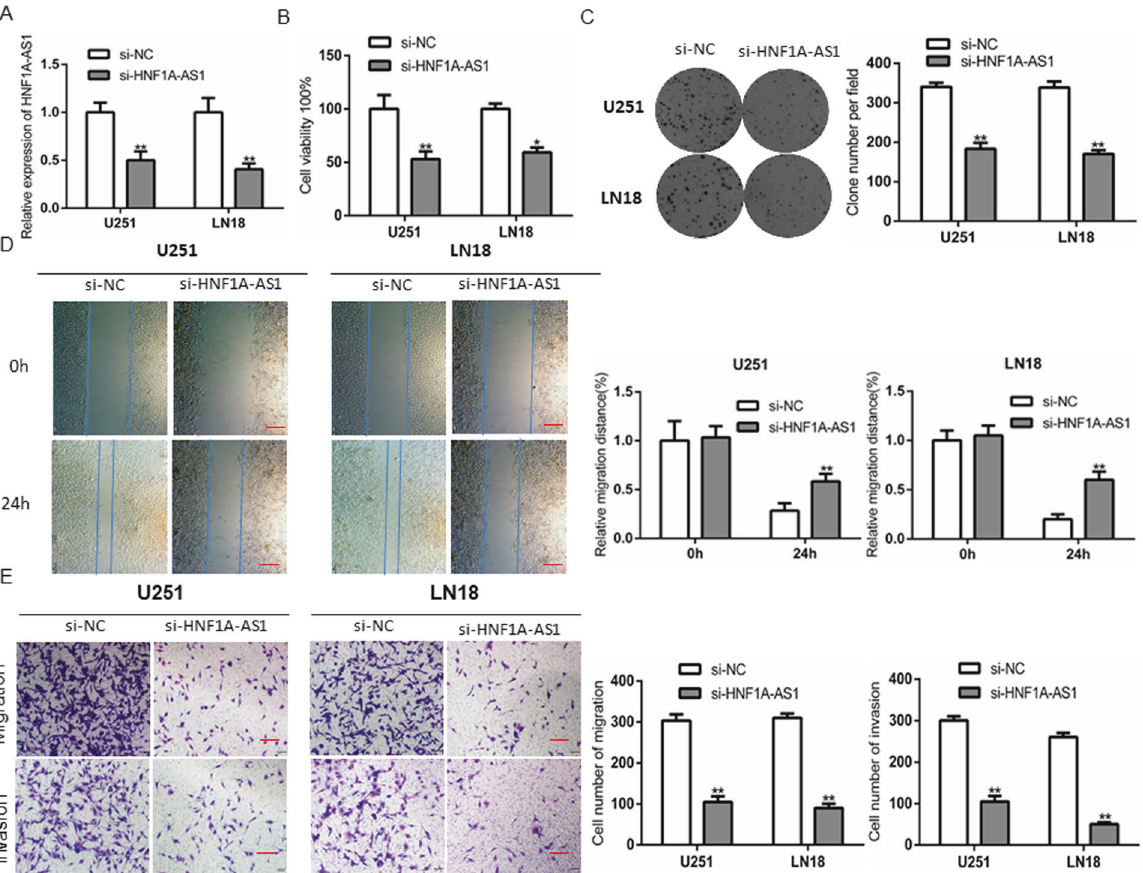
Fig. 2 Knockdown of HNF1A-AS1 inhibited the proliferation, migration, and invasion of glioma cells in vitro. A Relative expression levels of HNF1A-AS1 after GBM cells transfected with si-HNF1A-AS1 and si-NC. ** P < 0.01 vs. si-NC. B CCK-8 assay was performed to determine the proliferation effect of si-HNF1A-AS1 and si-NC transfected U251 and LN18 cells. * P < 0.05, ** P < 0.01 vs. si-NC group. C Colony formation assay was performed to detect the proliferation of U251 and LN18 cells after transfected with si-HNF1A-AS1 and si-NC. ** P < 0.01 vs. si-NC group. D Wound healing assay to evaluate the effect of HNF1A-AS1 on cell migration in U251 and LN18 cells (scale bar: 200 μ m). ** P < 0.01 < 0.05 vs. si-NC group. E Transwell assay for testing cell migration and invasion capacity (scale bar: 200 μ m). ** P < 0.01 vs. si-NC group. Data are presented as mean ± SD from three independent